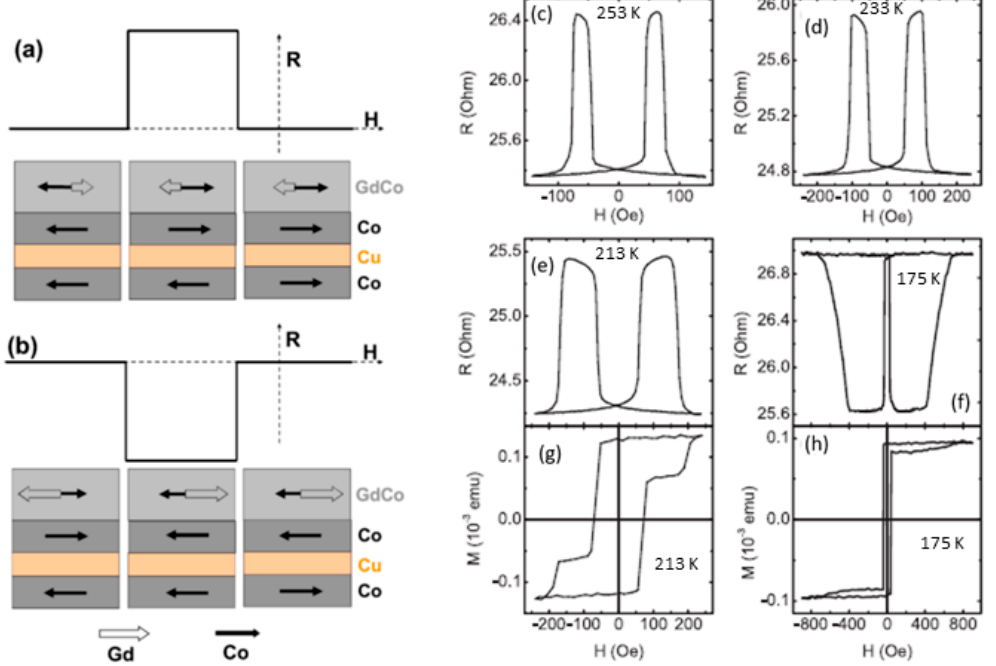
Figure 6. Schematic configurations of the magnetic moments of pure Co layers and Co and Gd sublattices of the Gd-Co layer, where the moment of Co total subnetwork is larger than that of Gd sublattices of the Gd-Co(35 nm)/Co(7 nm) composite layer at a temperature above the T comp ( a ) and vice versa, at a temperature below T comp ( b ). Magnetoresistance ( c – f ) and magnetic moment ( g , h ) loops for the Gd-Co(35 nm)/Co(7 nm)/Cu(4 nm)/Co(7 nm) spin valve measured at different temperatures: 253 K ( c ), 233 K ( d ), 213 K ( e , g ), and 175 K ( f , h ). The upper GdCo/Co bilayer act as the fixed layer in the spin valve, and the lower Co layer acts as the free one. Reprinted with permission from ref. [44] 2016 Elsevier with permission.